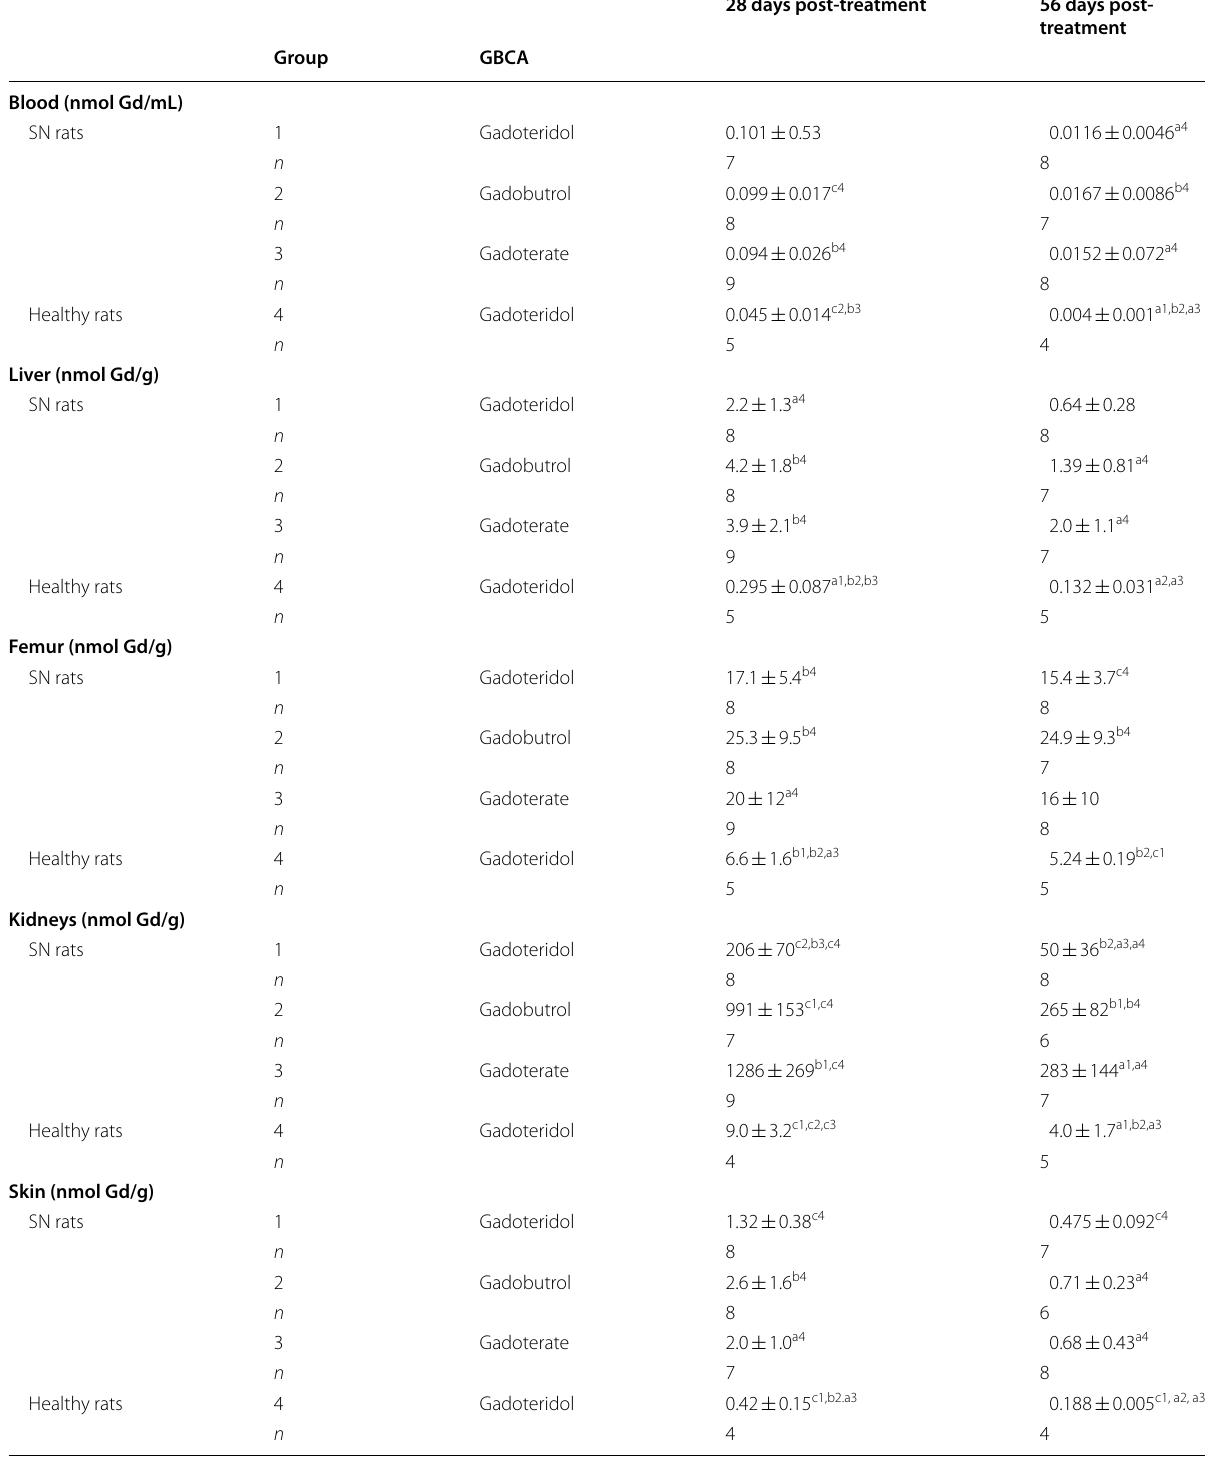
Table 2 Gadolinium content in the blood, liver, femur, kidneys, and